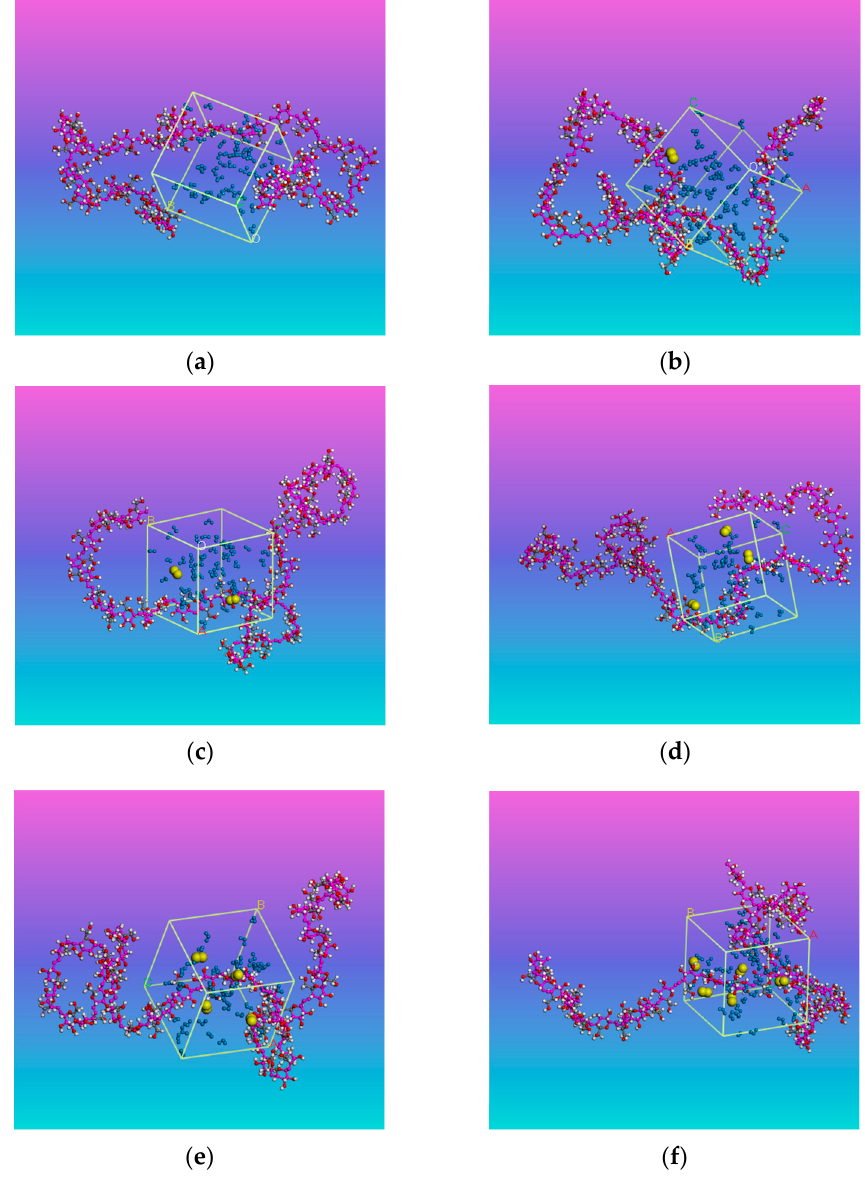
Figure 1. Cellulose-water-oxygen model: ( a ) Without oxygen; ( b ) With 2% oxygen; ( c ) With 4% oxygen; ( d ) With 6% oxygen; ( e ) With 8% oxygen; ( f ) With 10% oxygen. The long chain is cellulose chain, the small blue molecules in the cubic cell are water, and the small yellow molecules are oxygen.